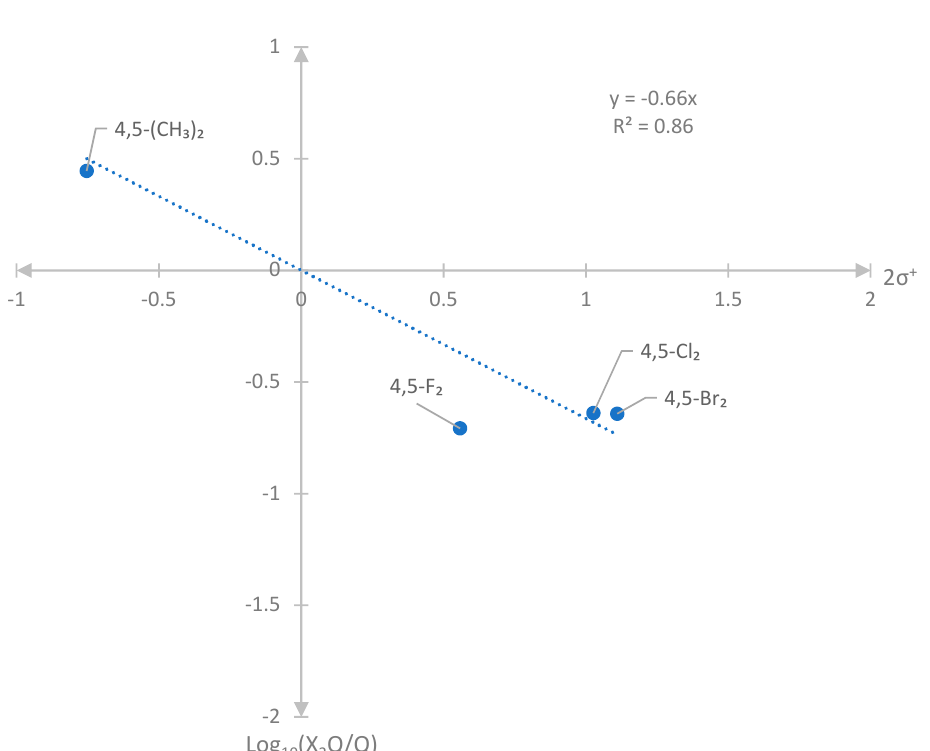
Figure 5. Hammett plot of X 2 Q/Q ratio with doubled standard composite σ constants.